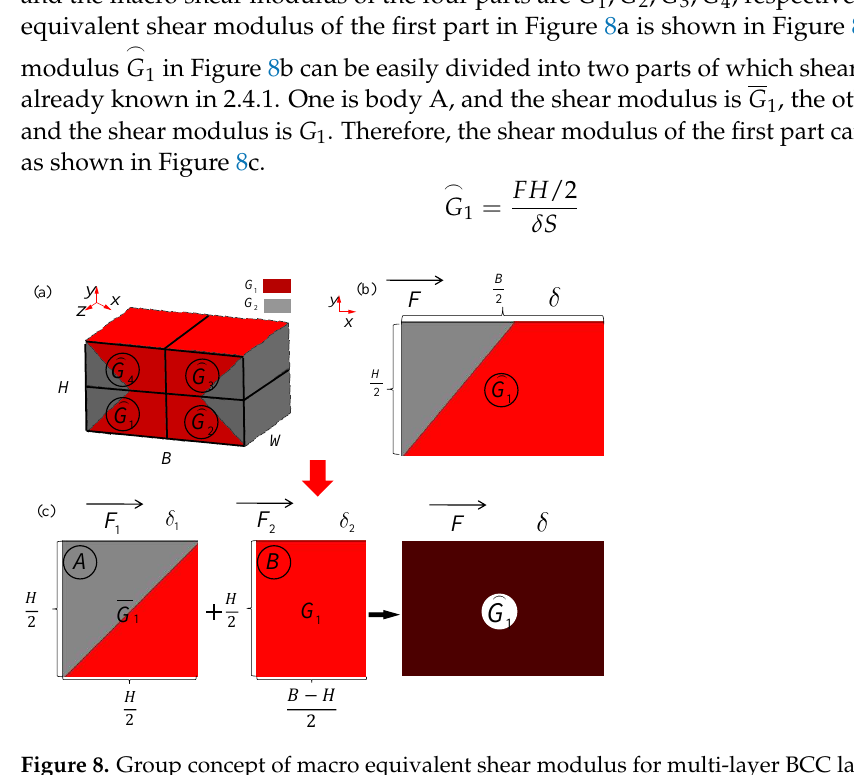
Figure 8. Group concept of macro equivalent shear modulus for multi-layer BCC lattice structures (H < B): ( a ) the whole model; ( b ) the first part; ( c ) the representative unit calculation in x - y plane.